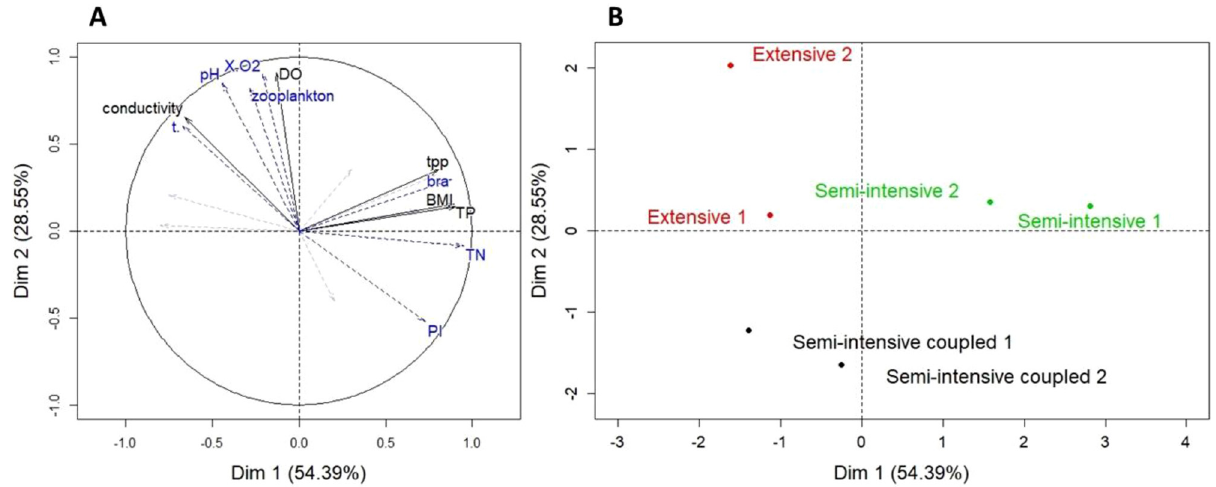
Fig. 5. (A) Correlation circle of the principal component analysis. Only explanatory variables (solid black arrows) and supplementary variables (dashed blue arrows) with cos 2 ≥ 0.75 are shown. Arrows without names are supplementary variables with cos 2 < 0.75. TP is total phosphorus concentration, tpp is total chlorophyll concentration, DO is dissolved oxygen, BMI is estimated benthic macro-invertebrate production, PI is fi sh production intensity, t. is water temperature, X.O2 is oxygen saturation, TN is total nitrogen concentration, bra is chlorophyll concentration from brown algae, and zooplankton is estimated zooplankton production. (B) Position of replicate fi shponds 1 and 2 of each treatment in the biplot of the principal component